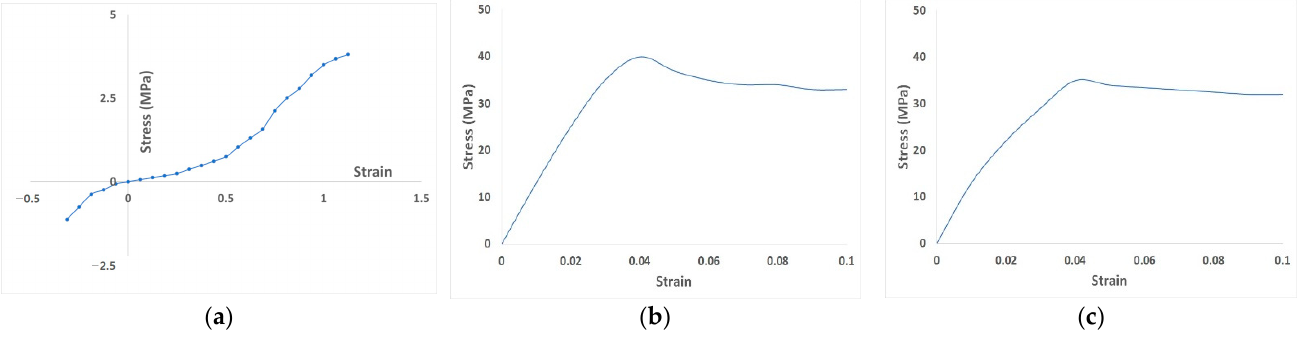
Figure 2. Stress ‒ strain curve for nonlinear material properties of ( a ) periodontal ligaments (PDLs) [21], ( b ) 0.5-mm thick, and ( c ) 0.75-mm thick transparent aligner obtained through testing [22].